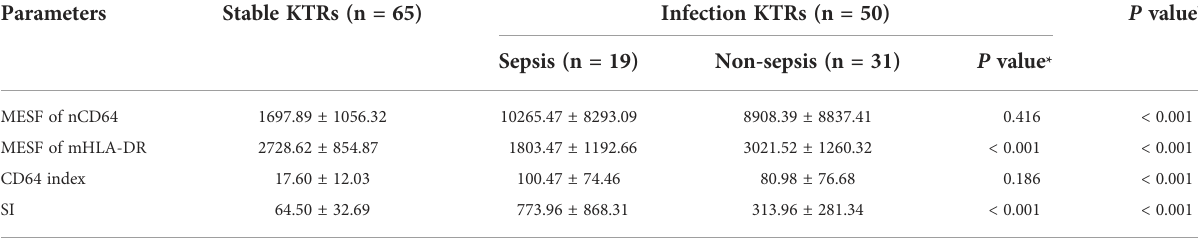
*Comparison between the sepsis patients and non-sepsis patients. # Comparison among the three groups. Tested by the least signi fi cant difference test for back testing of multivariate ANOVA. KTRs, kidney transplant recipients; nCD64, neutrophil CD64; mHLA-DR, monocyte HLA-DR; MESF, molecules of equivalent soluble fl uorochrome; SI, sepsis index.